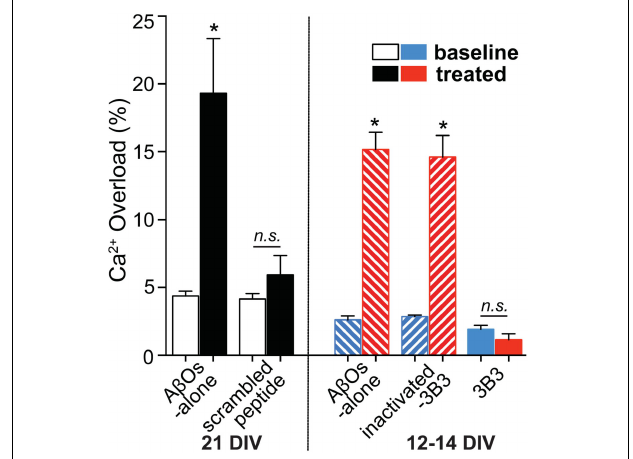
FIGURE 8 | The relationship of A β Os and neuronal calcium homeostasis in the presence and absence of ACU3B3 was studied in primary cultures of transgenic APP-PS1 mouse cortical neurons (Wang et al., 2018). Multiphoton microscopy was used to obtain images of neuronal cultures at 12–14 days in vitro (DIV), or 21 DIV. Cortical regions were identified and reimaged before and after topical applications of A β Os to allow comparison of resting calcium within the same neuronal compartments. After baseline calcium measurement, the cultures were treated with antibody-immunodepleted A β Os (1 mL of 3 nM A β Os with 9 µ g of antibody) or A β O alone (150–180 pM) for 45 min. The cultures were then re-imaged in the same areas in the dish. A β O assembly